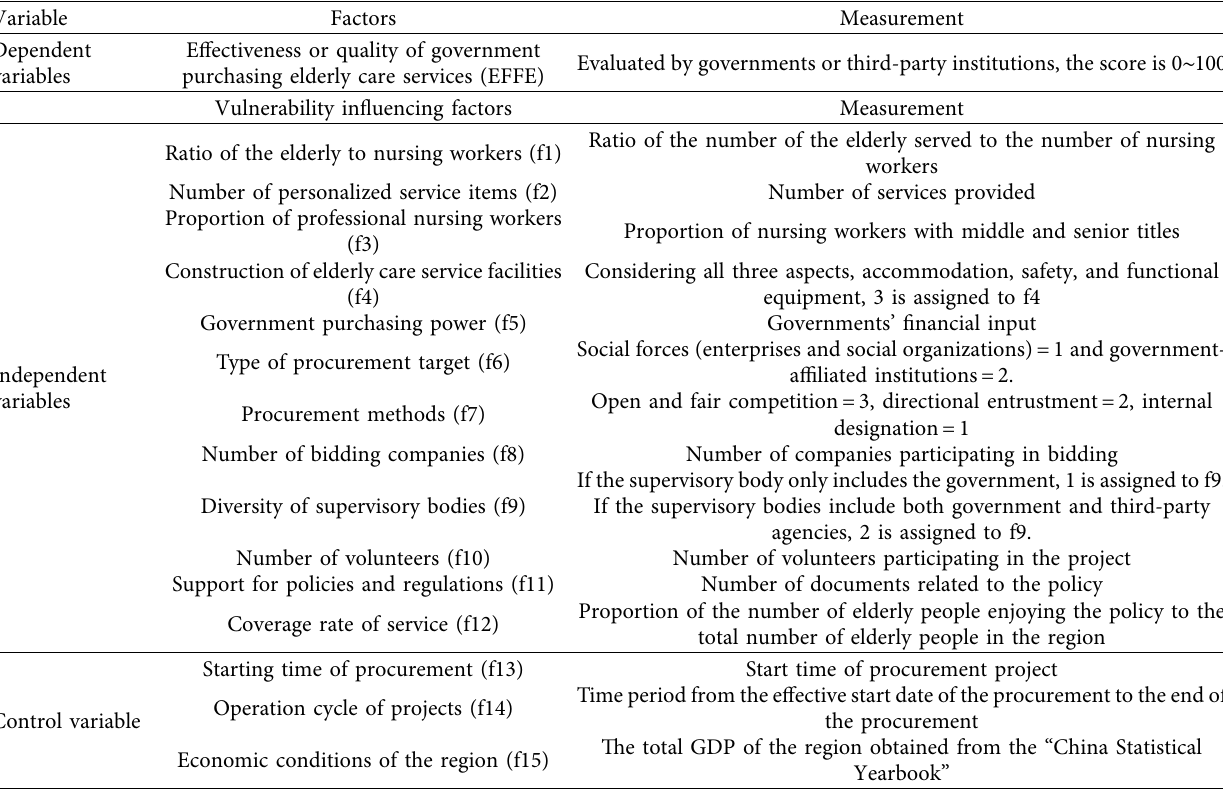
Table 2: Summary of variables and the measurement method.